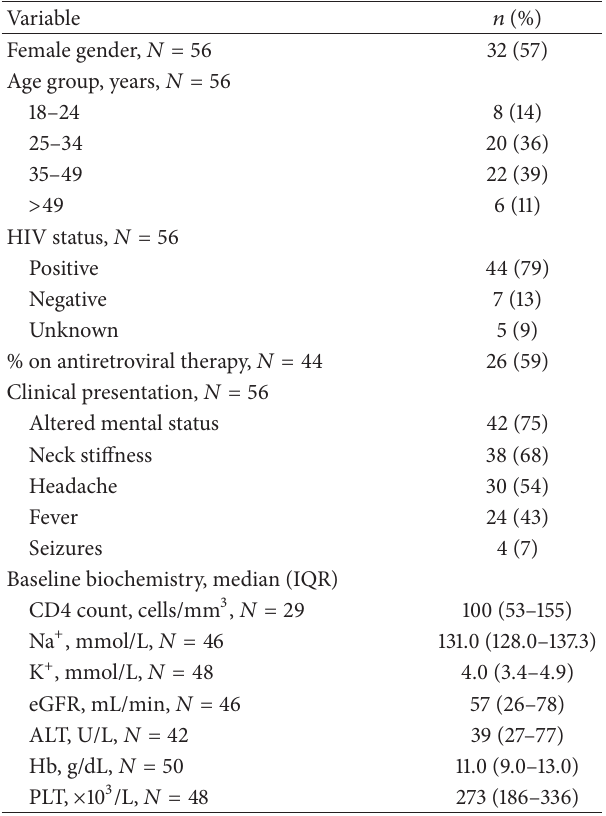
Table 1: Demographic and baseline characteristics of the study